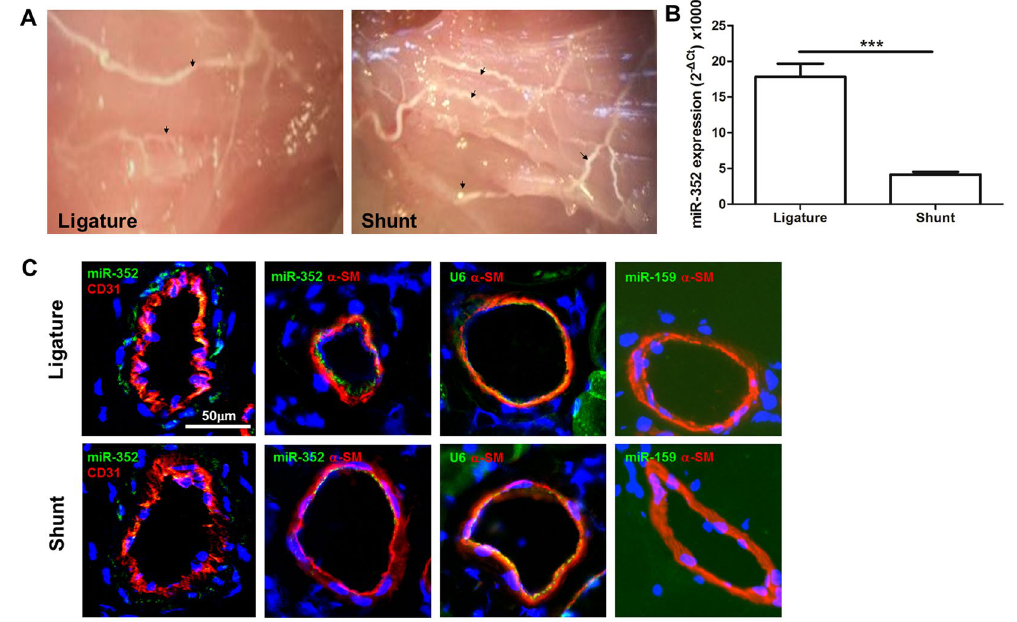
Figure 1. Expression of miR-352 in collateral vessels of the ligature-only side (LO) and the AV-shunt side (AVS). ( A ) Collateral vessels that were infused with liquid latex in the superficial adductor muscles from both the LO and AVS. An increased number of collaterals was evident in the AVS (indicated by arrows); original magnification: 10 × . ( B ) Quantitative analysis of miR-352 expression by stem-loop qPCR in LO and AVS collateral vessels from each animal ( *** P < 0.001, n = 5). ( C ) In situ hybridization from miR-352 in collateral vessels of the LO and AVS. Green fluorescence and red fluorescence for CD31 and α -SM-actin, respectively. The U6 probe was used as a positive control, and miR-159 served as a negative control because this miRNA is not expressed in mammalian tissue. Notably, miR-352 was present mainly in endothelial and smooth muscle cells of the collateral vessels, and its expression was decreased in collateral vessels of the AVS as compared with those in the